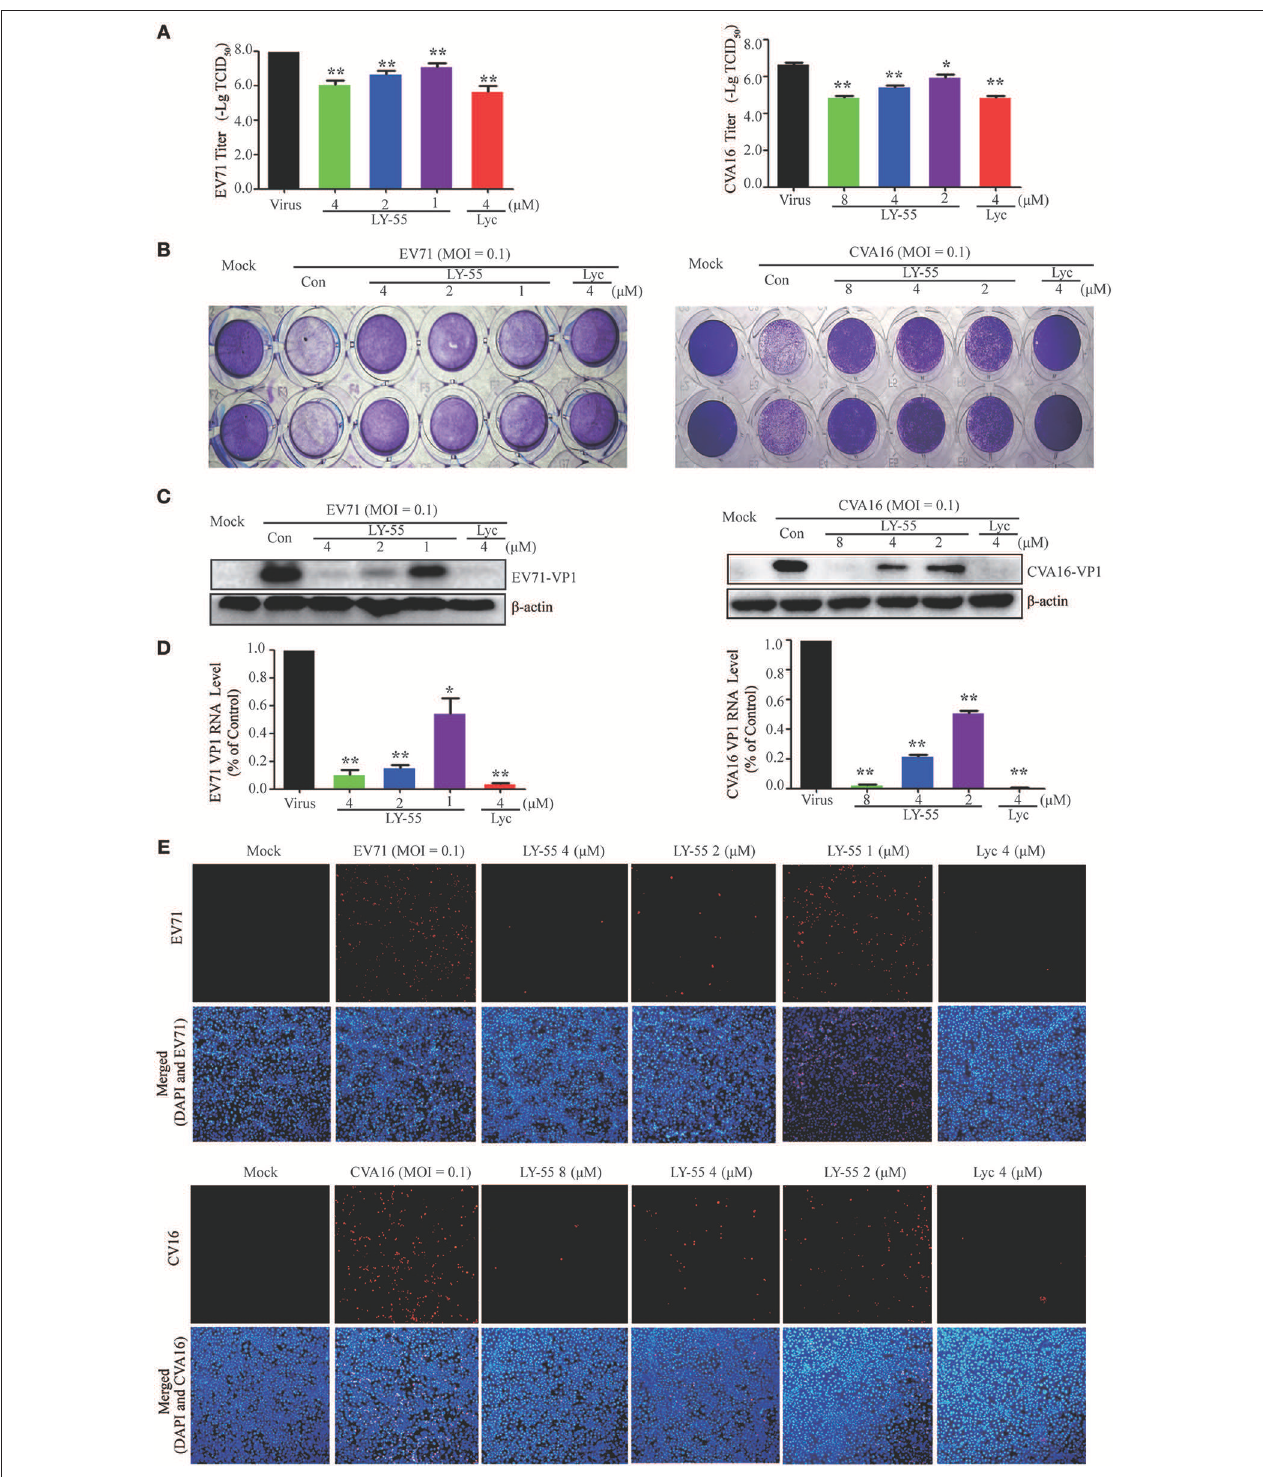
FIGURE 2 | LY-55 inhibited EV71 and CVA16 replication in vitro . (A) Inhibition of viral titer by LY-55. (B) Effects of LY-55 on EV71 or CVA16-induced CPE in Vero cells were determined via crystal violet staining. (C,D) Vero cells (9 × 10 5 cells/well) were plated into 6-well culture plates and infected with EV71 or CVA16 (MOI = 0.1) for 1h. The infected cells were treated with the indicated concentrations of LY-55 for 24h. Intracellular viral VP1 protein (C) and RNA (D) were determined by using Western blot and qRT-PCR assays, respectively. ** P < 0.01, * P < 0.05. (E) EV71 or CVA16-infected cells were revealed by using immunofluorescent detection of VP1 protein by using fluorescence microscopy ( ×